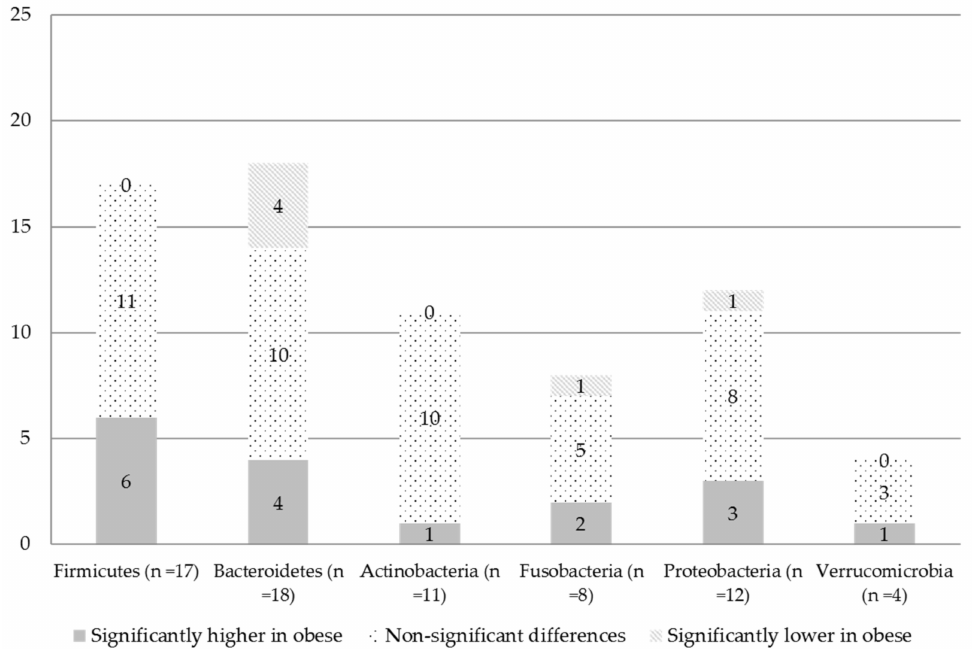
Figure 5. Number of studies that reported differences in the relative abundance of phyla as signif- icantly higher (grey), lower (diagonal stripes) or not different (dotted) when comparing obese to non-obese